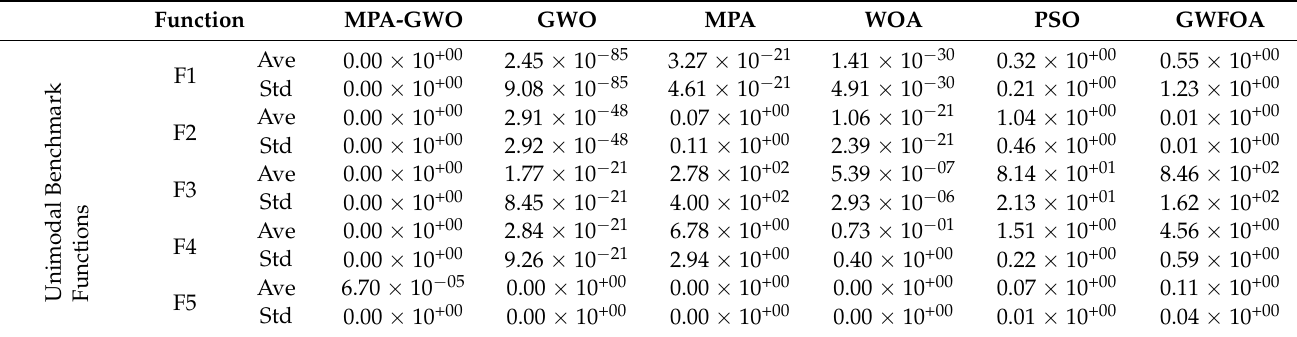
Figure A1. Convergence curves for 15 benchmark functions. ( a ) Convergence curves for F1. ( b ) Convergence curves for F2. ( c ) Convergence curves for F3. ( d ) Convergence curves for F4. ( e ) Convergence curves for F5. ( f ) Convergence curves for F6. ( g ) Convergence curves for F7. ( h ) Convergence curves for F8. ( i ) Convergence curves for F9. ( j ) Convergence curves for F10. ( k ) Convergence curves for F11. ( l ) Convergence curves for F12. ( m ) Convergence curves for F13. ( n ) Convergence curves for F14. ( o ) Convergence curves for F15. Table A1. Optimization results and comparison for functions.